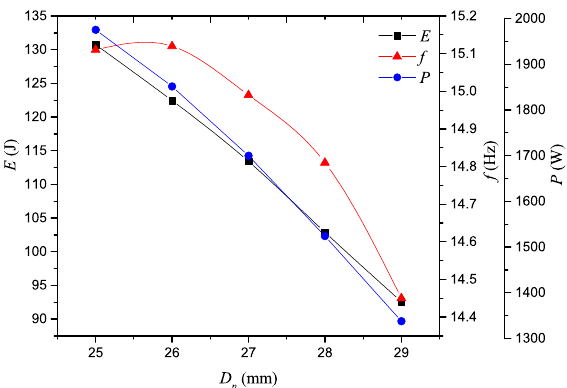
Figure 7. Variations of single ‐ impact energy E , impact frequency f, and output power P versus diameter of the piston D p .